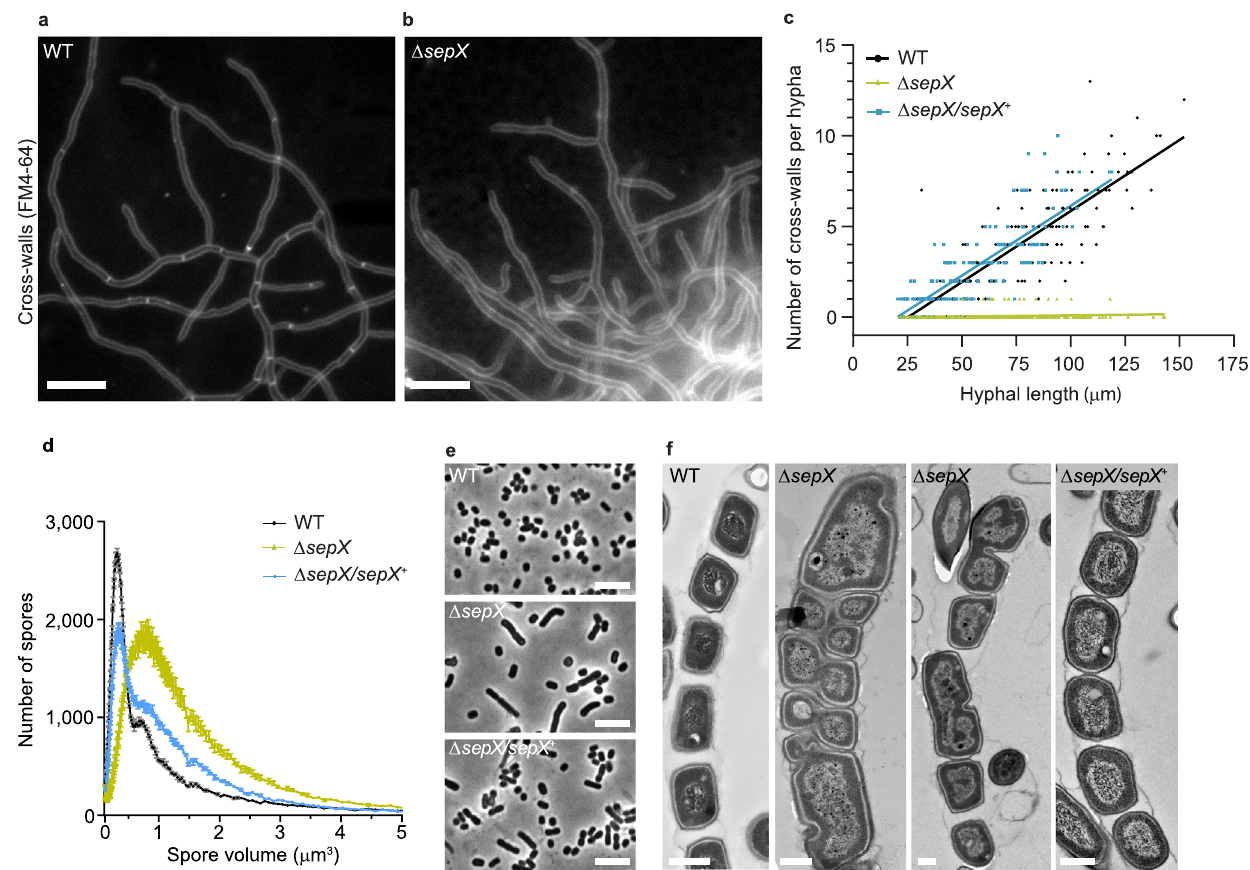
Fig. 2 SepX is required for vegetative cross-wall formation and regular sporulation septation. a Vegetative septa can be visualized by fl uorescence microscopy after incubating wild-type (WT) S. venezuelae hyphae with the membrane dye FM4-64. b The sepX deletion strain (SV55) lacks septa in growing hyphae, as visualized by FM4-64 staining. Scale bars in a and b : 10 μ m. Data shown in a and b are representatives of experiments performed in triplicate. c Quanti fi cation of cross-wall frequency in hyphae emerging from spores of the wild type (WT), the Δ sepX mutant (SV55) and the complemented mutant Δ sepX/sepX + (MB745). Cross-walls were visualized by growing the strains in the presence of 0.25 mM HADA for 5 – 6 h following germination. Data were derived from triplicate experiments and at least 20 spores per replicate were analyzed. Solid lines represent simple linear regression. d Spore volume frequency distributions (normalized to total count, n = 100,000) of the wild type (WT), the Δ sepX mutant (SV55) and the complemented mutant (MB181). Shown is the mean ± s.e.m. of three biological replicates per strain. e Representative phase contrast images of spores analyzed in ( d ). Data shown are representatives of experiments performed in triplicate. Scale bars: 5 μ m. f TEM images of sporulating hyphae in the wild type (WT), the Δ sepX mutant (SV55) and the complemented mutant Δ sepX / sepX + (MB181). Scale bars: 500 nm. Shown are representative images of at least 5 independent hyphae. Source data are provided as a Source Data fi le for ( c ) and ( d ).